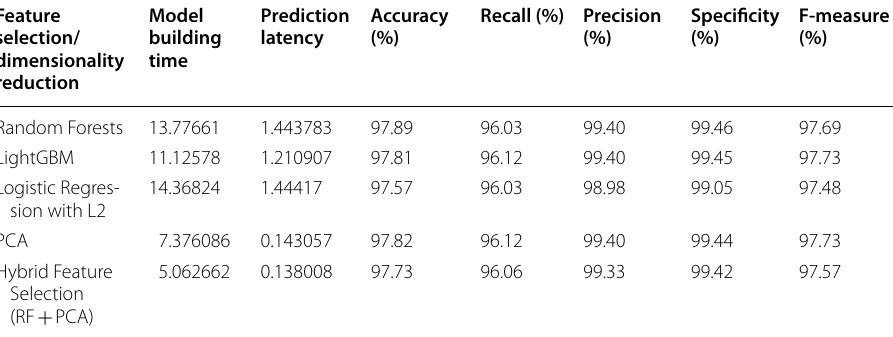
Table 9 Performance of Hybrid Feature Selection with other feature selection/dimensionality reduction